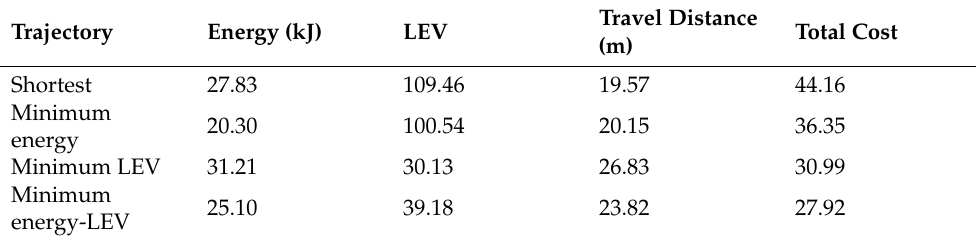
Table 7. Experimental results of trajectory